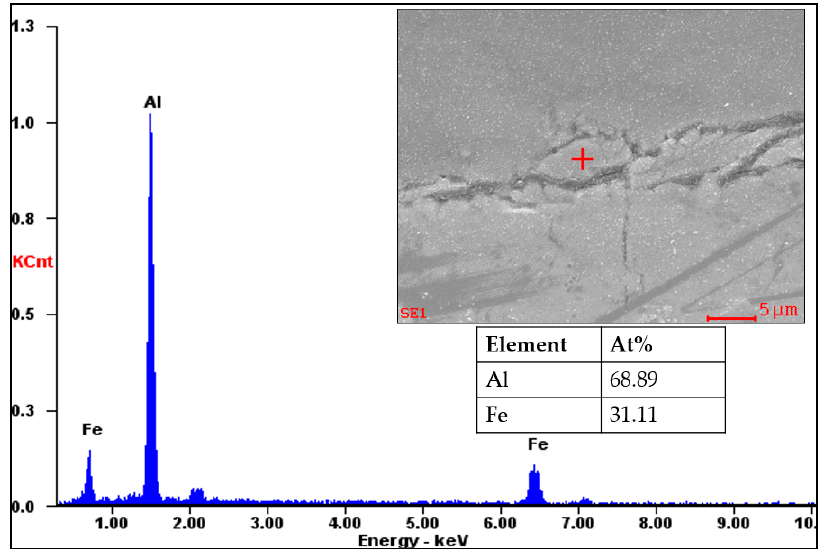
Figure 6. Results of the EDS point analysis of the intermetallic layer of a flaked sample.